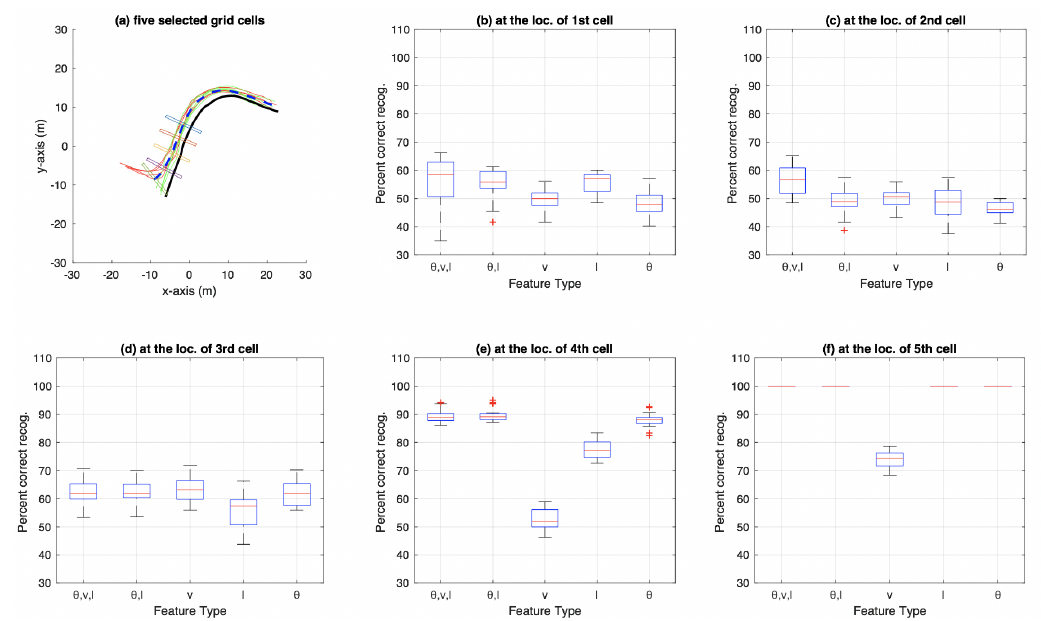
Figure 10. Aggregate results for bicycle dataset using decision trees.